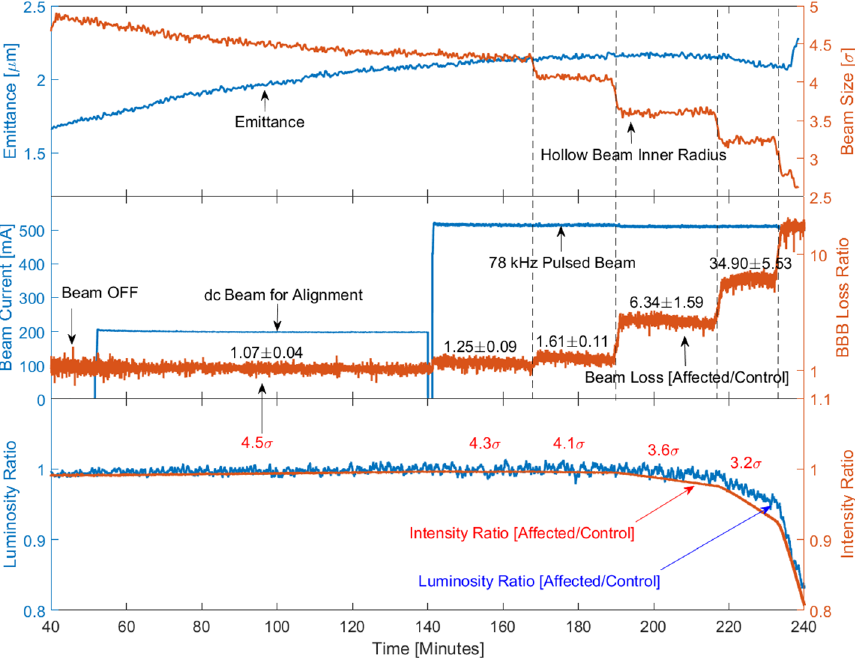
FIG. 15. Overview of the radius scan experiments. The top plot shows the average (horizontal and vertical) emittance of the affected bunch train. The middle plots are the electron beam current and beam BBB loss ratio during experiments. The bottom plot shows the normalized average intensity and the average